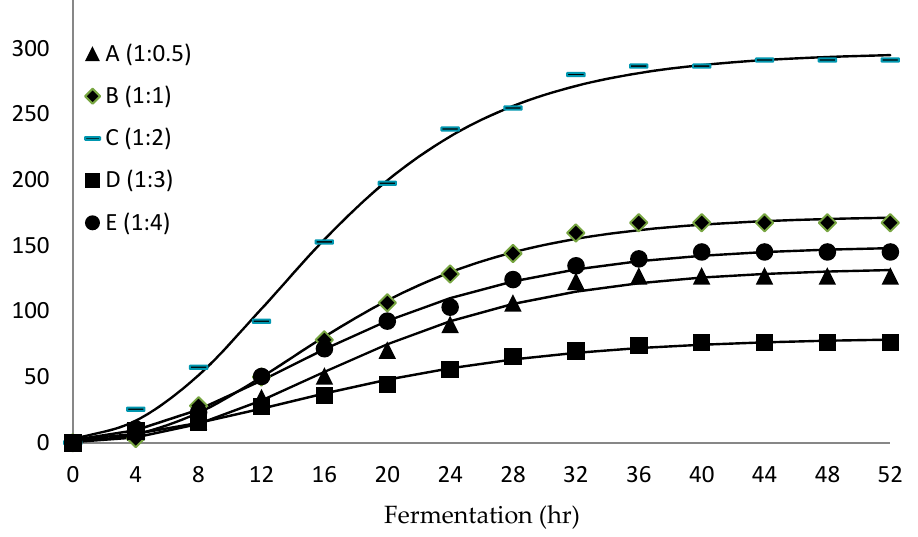
Figure 5. Hydrogen production (mL) at different concentrations of chitosan in 200 mL of a 250 mL modified bioreactor in batch fermentation.